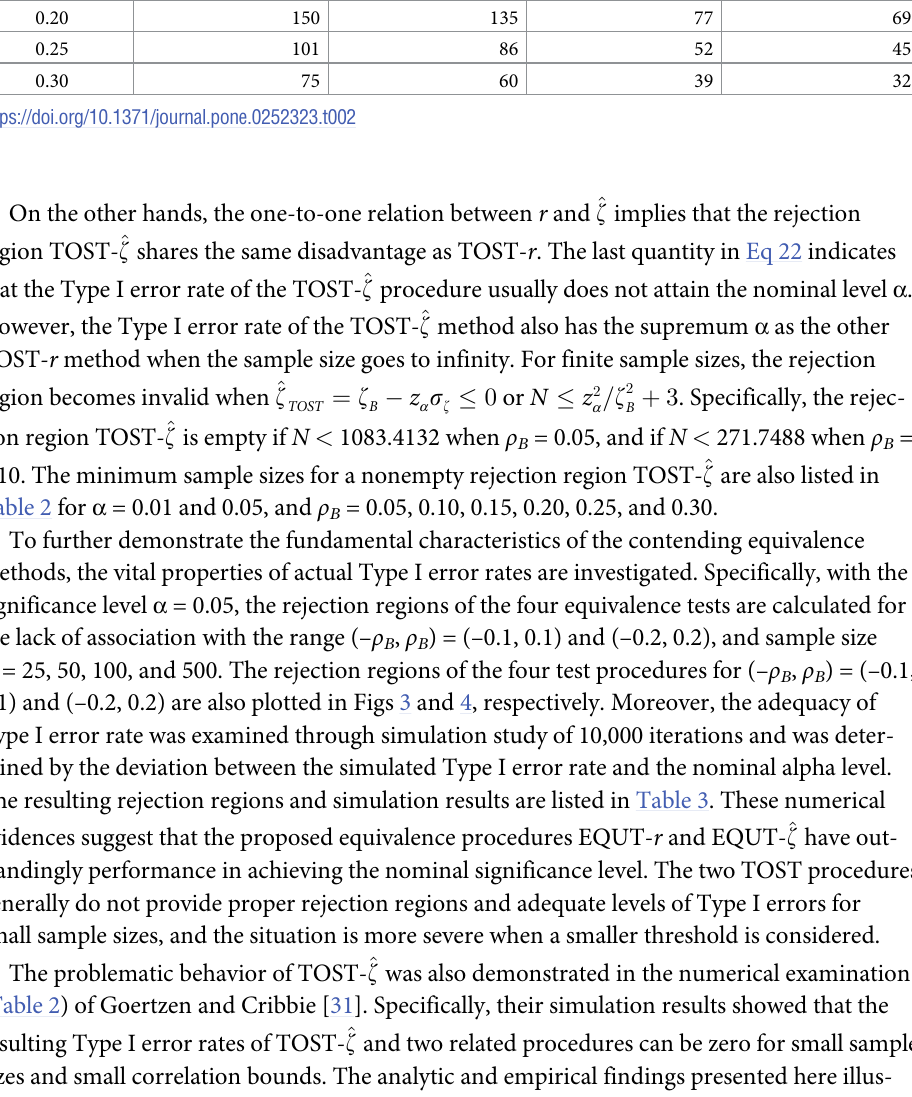
Table 2. The minimum sample sizes of TOST procedures to have a nonempty critical interval for detecting a lack of